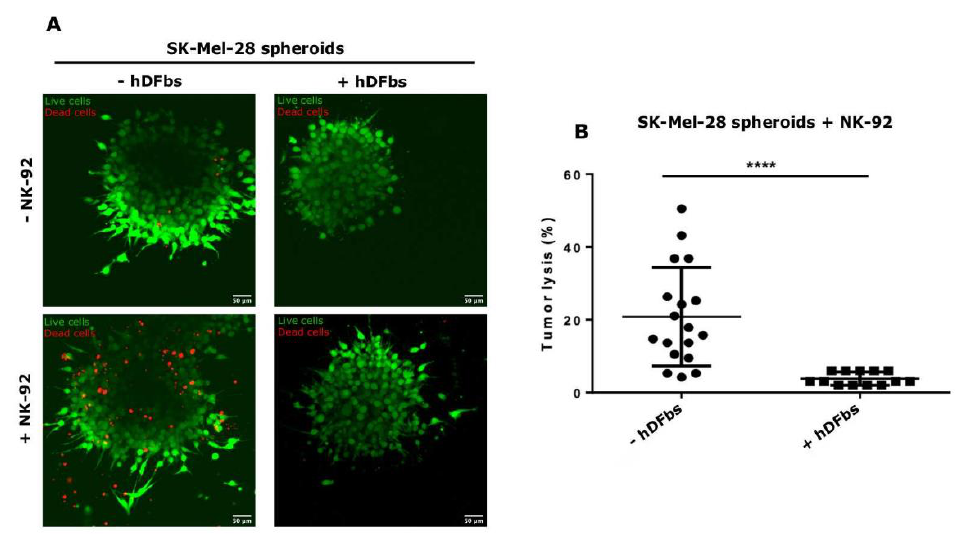
Figure 3. NK-92 cytotoxicity: ( A ) Representative confocal images of NK-92 cytotoxicity inhibition. Magnification, 20 × . Scale bar, 50 µ m. All images were acquired in fluorescence (live cells in green, em. 488, calcein; dead cells in red, em. 555, PI). On the left, monoculture of SK-Mel-28 spheroids. On the right, co-culture of SK-Mel-28 and hDFbs spheroids. In the bottom images, NK-92 were added into the culture. On the top, control experiments of spheroids without NK-92. ( B ) Plot shows the analysis of the cytotoxic inhibition of NK-92, significantly higher when hDFbs were added in the culture (“****” p < 0.005, unpaired t -test with Welch’s correction) (SK-Mel-28, n = 18; SK-Mel-28 + hDFbs, n = 13).